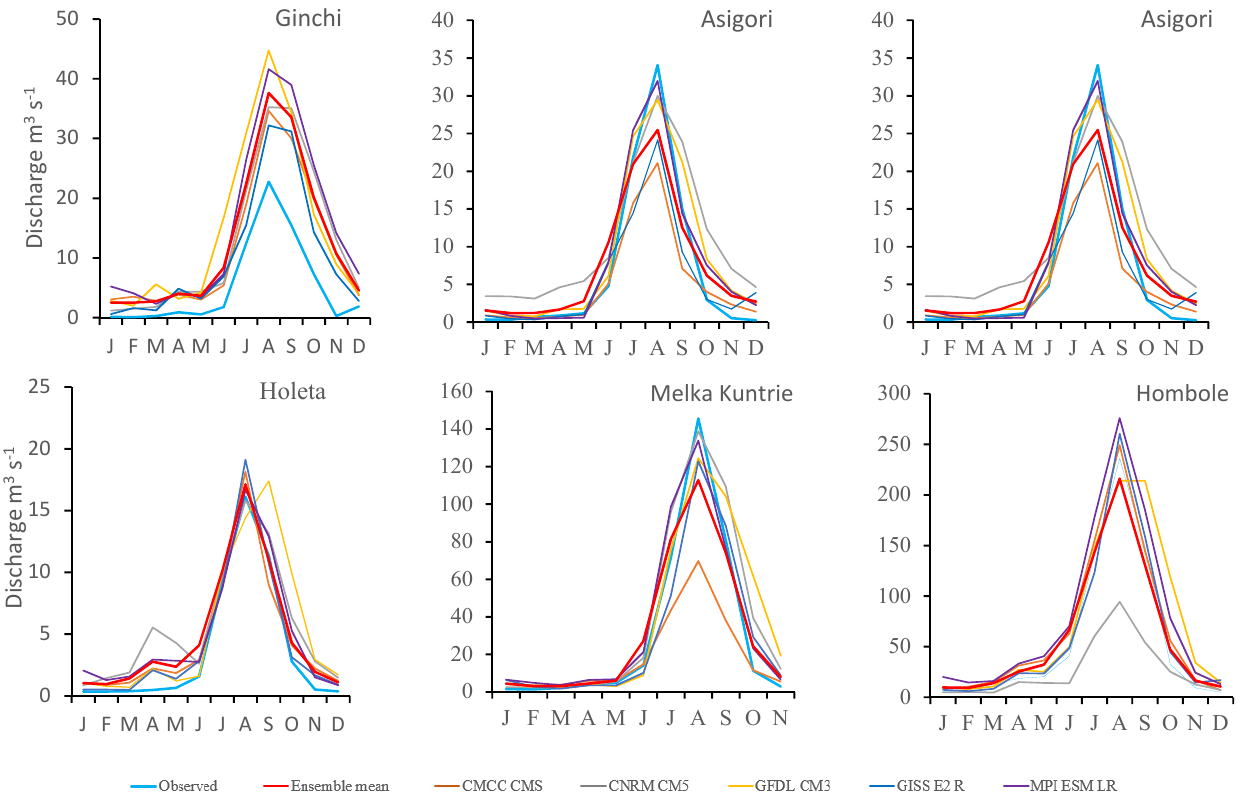
Figure 6. Mean monthly streamflow for the baseline, each GCM, and the ensemble mean.